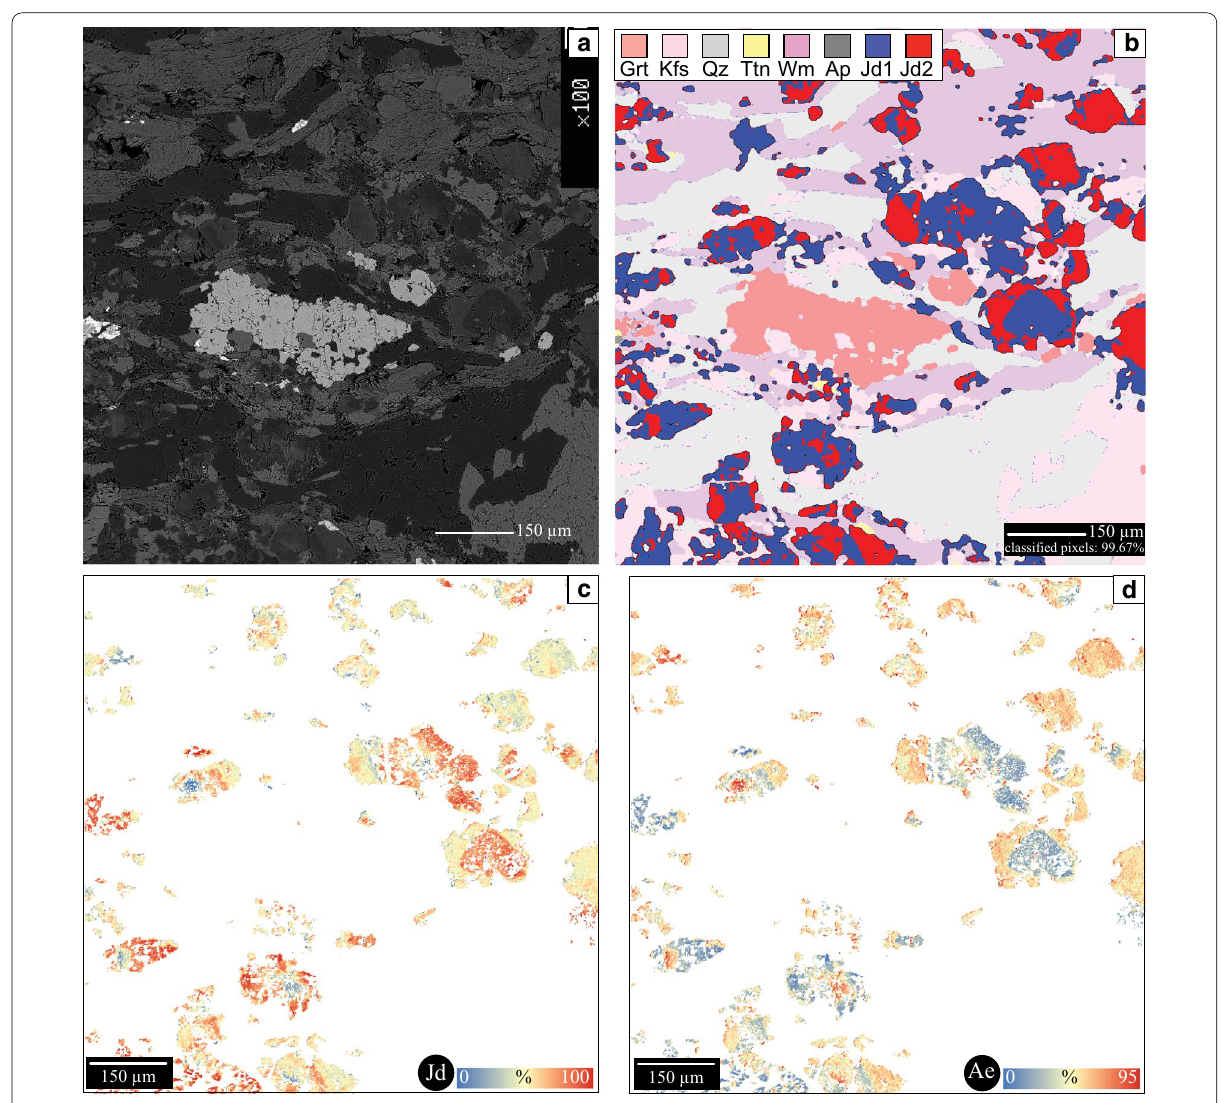
Fig. 12 Results of Q-XRMA second and third cycle for orthogneiss (ZR19-C0 microdomain). a Back-Scattered Electron (BSE) image of Fig. 6f, rotated of 90 degree. b Result of second cycle showing Cpx generations classification and mineral classification of X-ray map. Two generations for Cpx can be detected. Jd1 are the porphyroclasts and Jd2 partially replaces Jd1. The amount of pixels classified is 99.67%. Result of third cycle showing ( c ) jadeite (Jd) and aegirine ( d ) component (Ae) map for all Cpx of the X-ray map. Aeg exsolutions locally occur at the core of Jd close to fractures crossing Jd